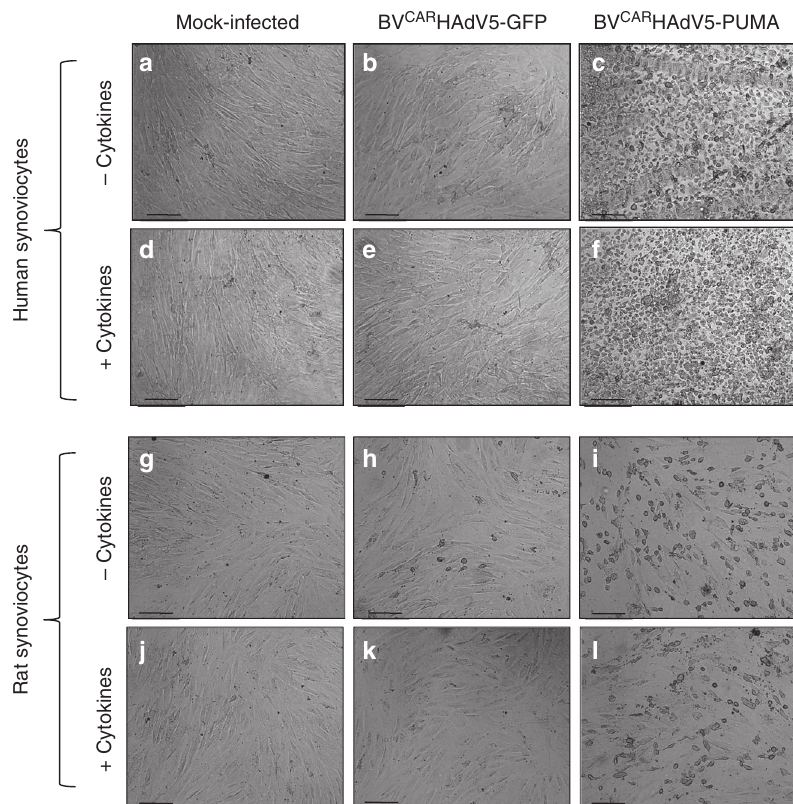
Fig. 2 Cell death of human and rat FLS induced by BV CAR HAdV5-PUMA. Cultures of human and rat FLS were non-treated a – c , g – i or treated d – f , j – l with proin fl ammatory cytokines, TNF α and IL-17. The FLS samples were mock-infected a , d , g , j , infected with BV CAR HAdV5-GFP b , e , h , k or infected with BV CAR HAdV5-PUMA c , f , i , l . Note the rounding-up of FLS after transduction with BV CAR HAdV5-GFP in c , f , i , l . Scale bars, 20 μ